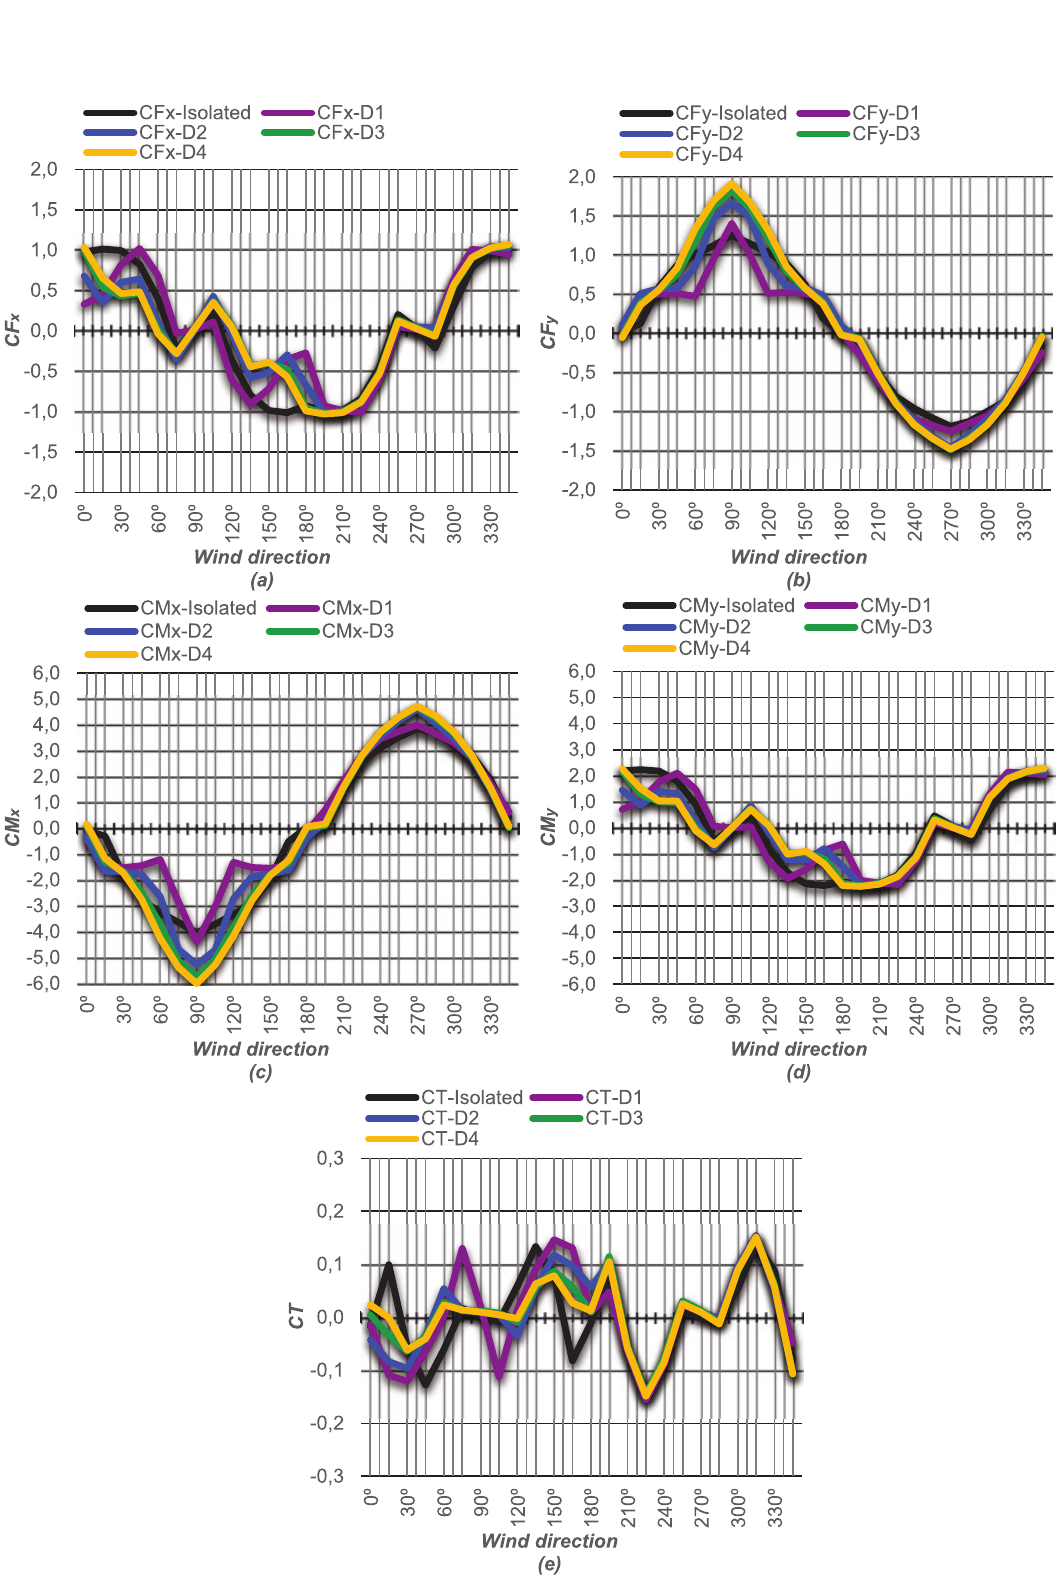
Figure 14 Load coefficients for the vicinity V7: (a) Resultant force in the direction of the X axis; (b) Resultant force in the direction of the Y axis; (c) Base momenta round axis X; (d) Base moment around axis Y; (e) Torsion around building